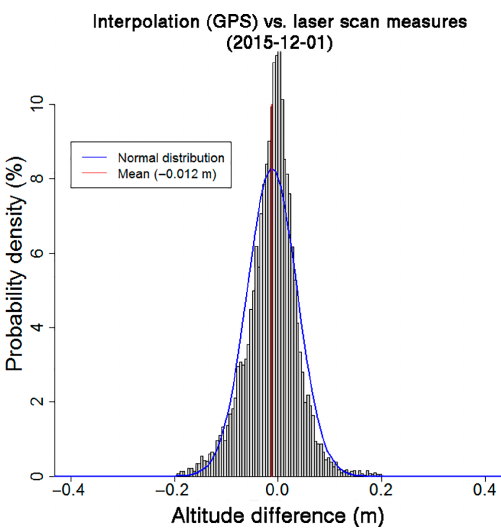
Figure B1. Probability density of the elevation differences between the interpolated snow surface and the TLS snow surface on 1 De- cember 2015.